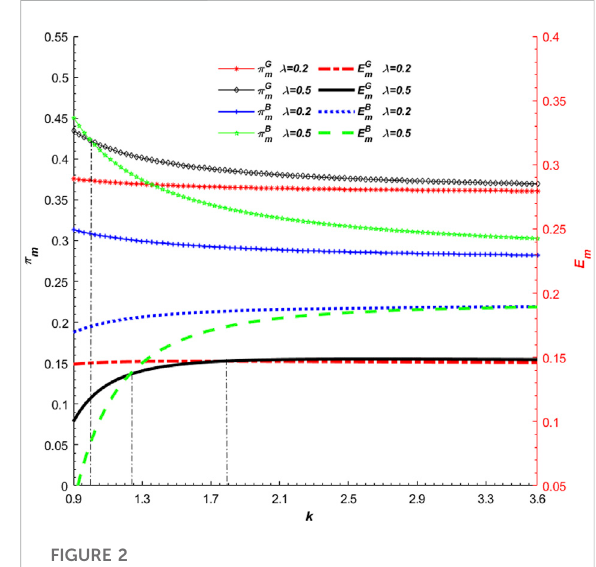
Effects of λ on total pro fi t and total carbon